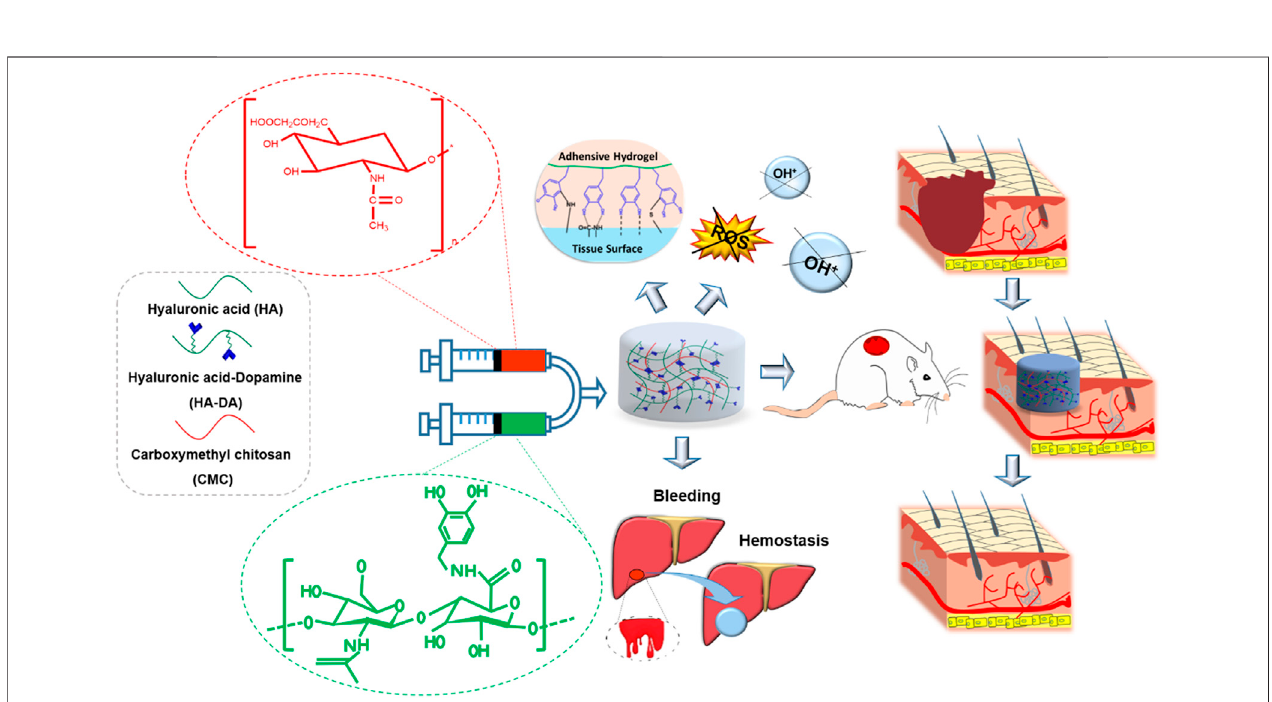
FIGURE 3 | Schematic illustration of the CMC/HA-DA hydrogel for wound repairing: the CMC/HA-DA hydrogel was synthesized by the enzyme cross-linking method with HRP/H 2 O 2 with its advantage of mild conditions; the CMC/HA-DA hydrogel not only has enhanced adhesive, antioxidant, and hemostatic ability but also was injectable, biodegradable, and biocompatible, which promise rapid wound closure (Cui et al., 2022).